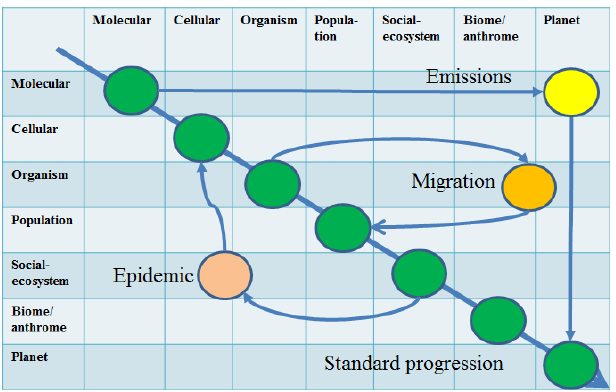
Fig. 2 . Levels of Life, a map showing the various microgame levels that make up the game. The player can progress linearly through game levels, but also discover “bonus” levels that each offer a combined perspective of phenomena playing out across system levels, such as migration, epidemics, and emissions. The aim of the game is to finish all the levels.